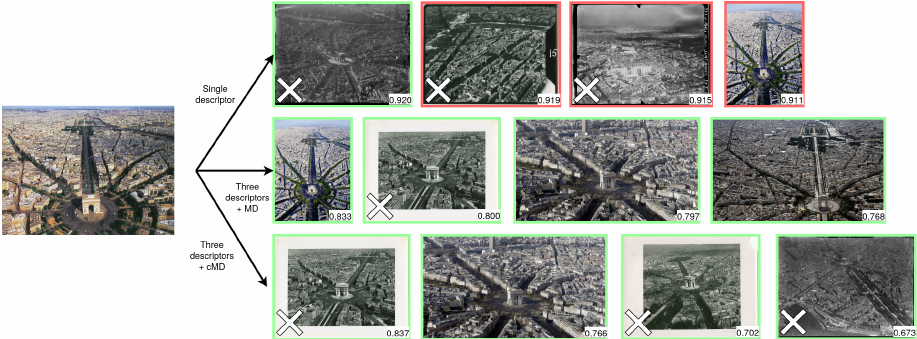
Figure 12. Query examples on the “Arc de Triomphe” class. First row: results using GeM-ArcFace trained on GoogleLandmarks (best performing single descriptor in Table 3). Second row: results using the three best performing descriptors + our proposed multi-descriptor diffusion (MD). Third row: results using the three best performing descriptors + our proposed constrained multi-descriptor diffusion (cMD). Positive results are indicated in green, negative in red. Similarity scores are indicated in the bottom right of each image. Cross-collection images (i.e., belonging to different collections) are indicated with a white cross on the bottom